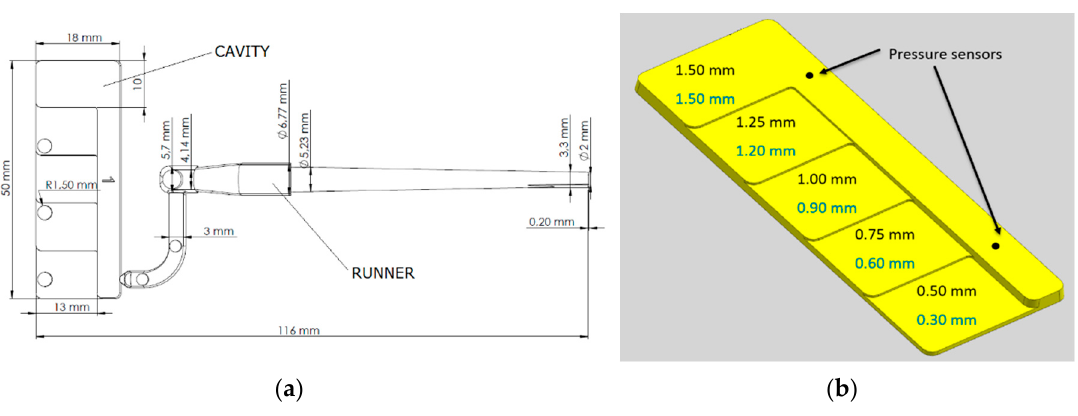
Figure2. ( a )TechnicaldrawingoftheinsertCavity1, comprehensiveofgateandrunner; ( b )Schematicof Figure 2. ( a ) Technical drawing of the insert Cavity 1, comprehensive of gate and runner; thecavity: inblackareshownthedimensionsofcavity1, inbluethedimensionsofcavity2. Thepositions ( b ) Schematic of the cavity: in black are shown the dimensions of cavity 1, in blue the dimensions of of the two sensors are also shown. Reproduced with permission from cavity 2. The positions of the two sensors are also shown. Reproduced with permission from [18].